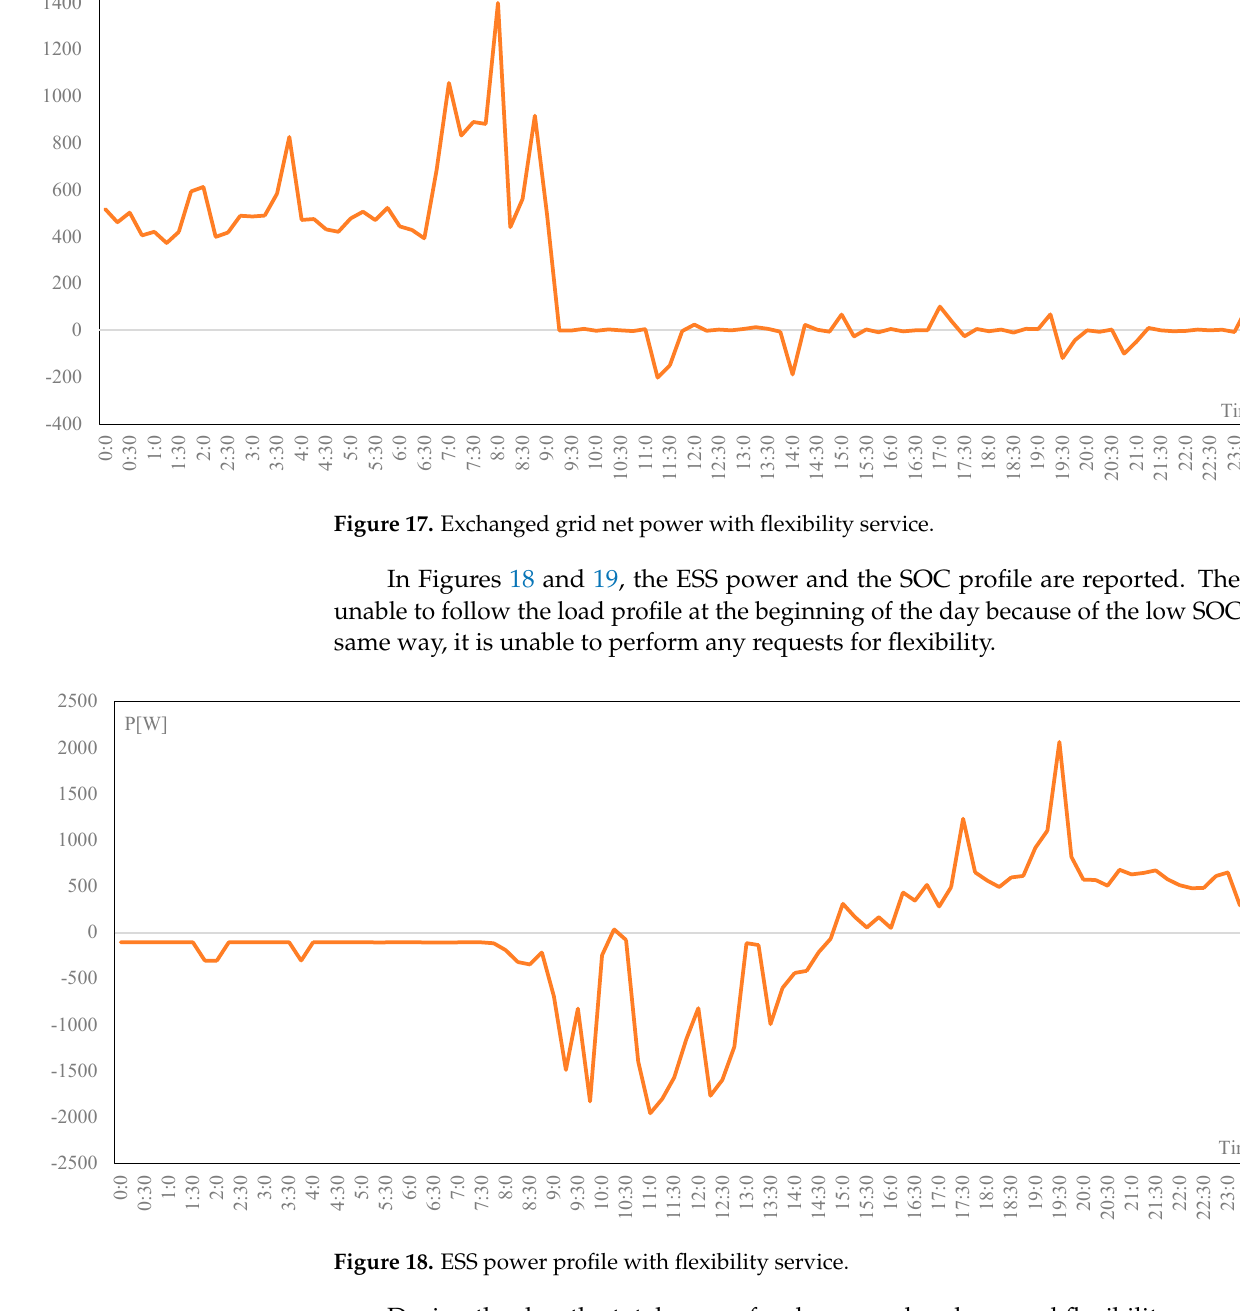
Figure 18. ESS power profile with flexibility service.